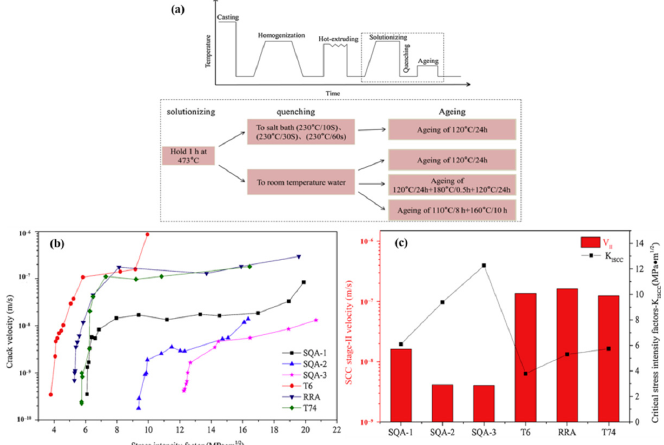
Figure 13. ( a ) Schematic diagram of heat treatment for the alloys investigated; ( b ) dependence of stress corrosion cracking propagation rate (v) and stress intensity factor (K I ) of different heat treatments specimens; ( c ) V Ⅱ and K ISCC values of different heat treatments. (Reprinted with permission from ref. [115]. Copyright 2019 Elsevier).